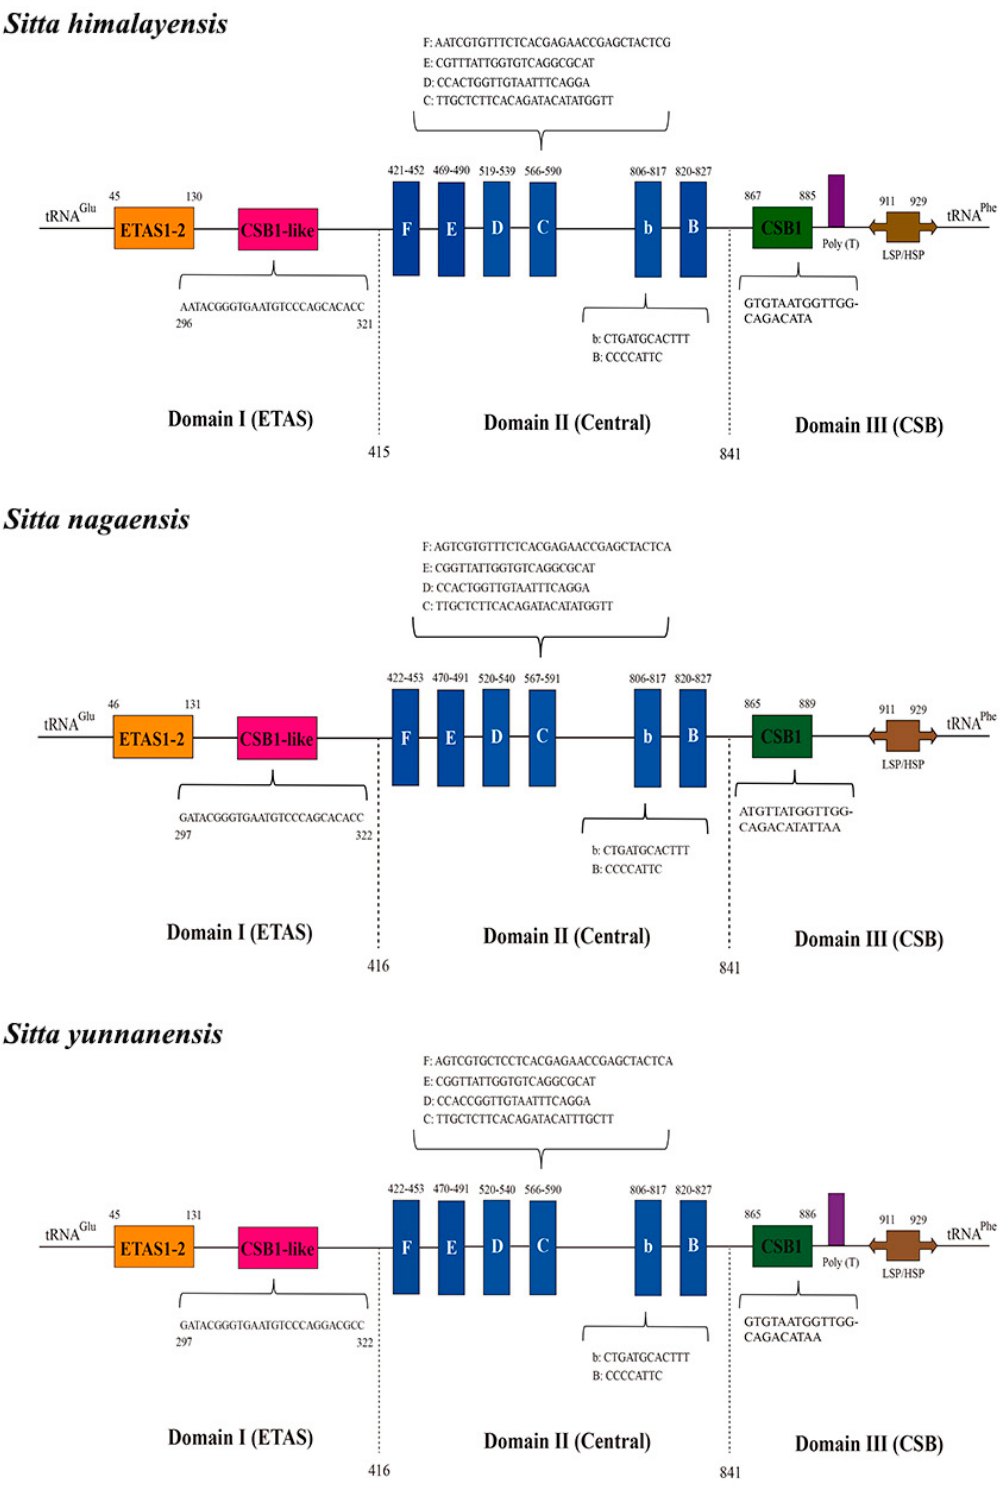
Figure 4. Predicted structural elements in the control region of three Sitta species. Extended termination-associated sequences are indicated by orange boxes, and conserved sequence blocks are indicated by blue boxes.